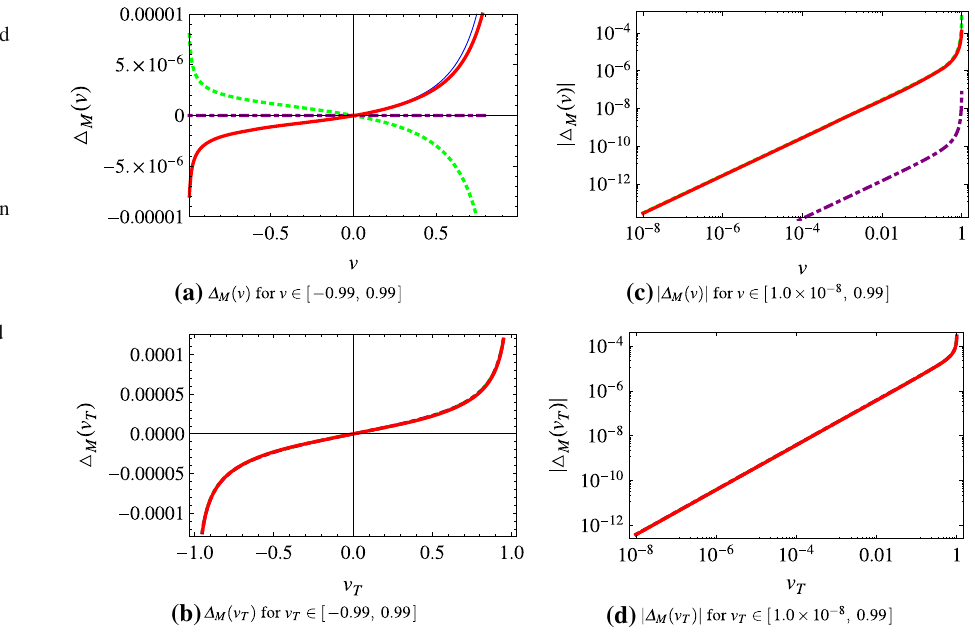
Fig. 3 Δ M (v) and Δ M (v T ) plotted as the functions of v and v T respectively in linear scale (left column). We also show | Δ (v) | , | Δ (v) | , and a M 2 | Δ (v) | vs v respectively in Q log-log scale (right column). { x , x } = {− 10 b , 5 b } A B (red), {− 1 . 0 × 10 5 b , 10 b } (thin blue), {− 10 b , 1 . 0 × 10 5 b } (dotted green), and {− 1 . 0 × 10 5 b , 2 . 0 × 10 5 b } (dot-dashed purple) for four different scenarios are assumed for comparison. b = 1 . 0 × 10 5 M is